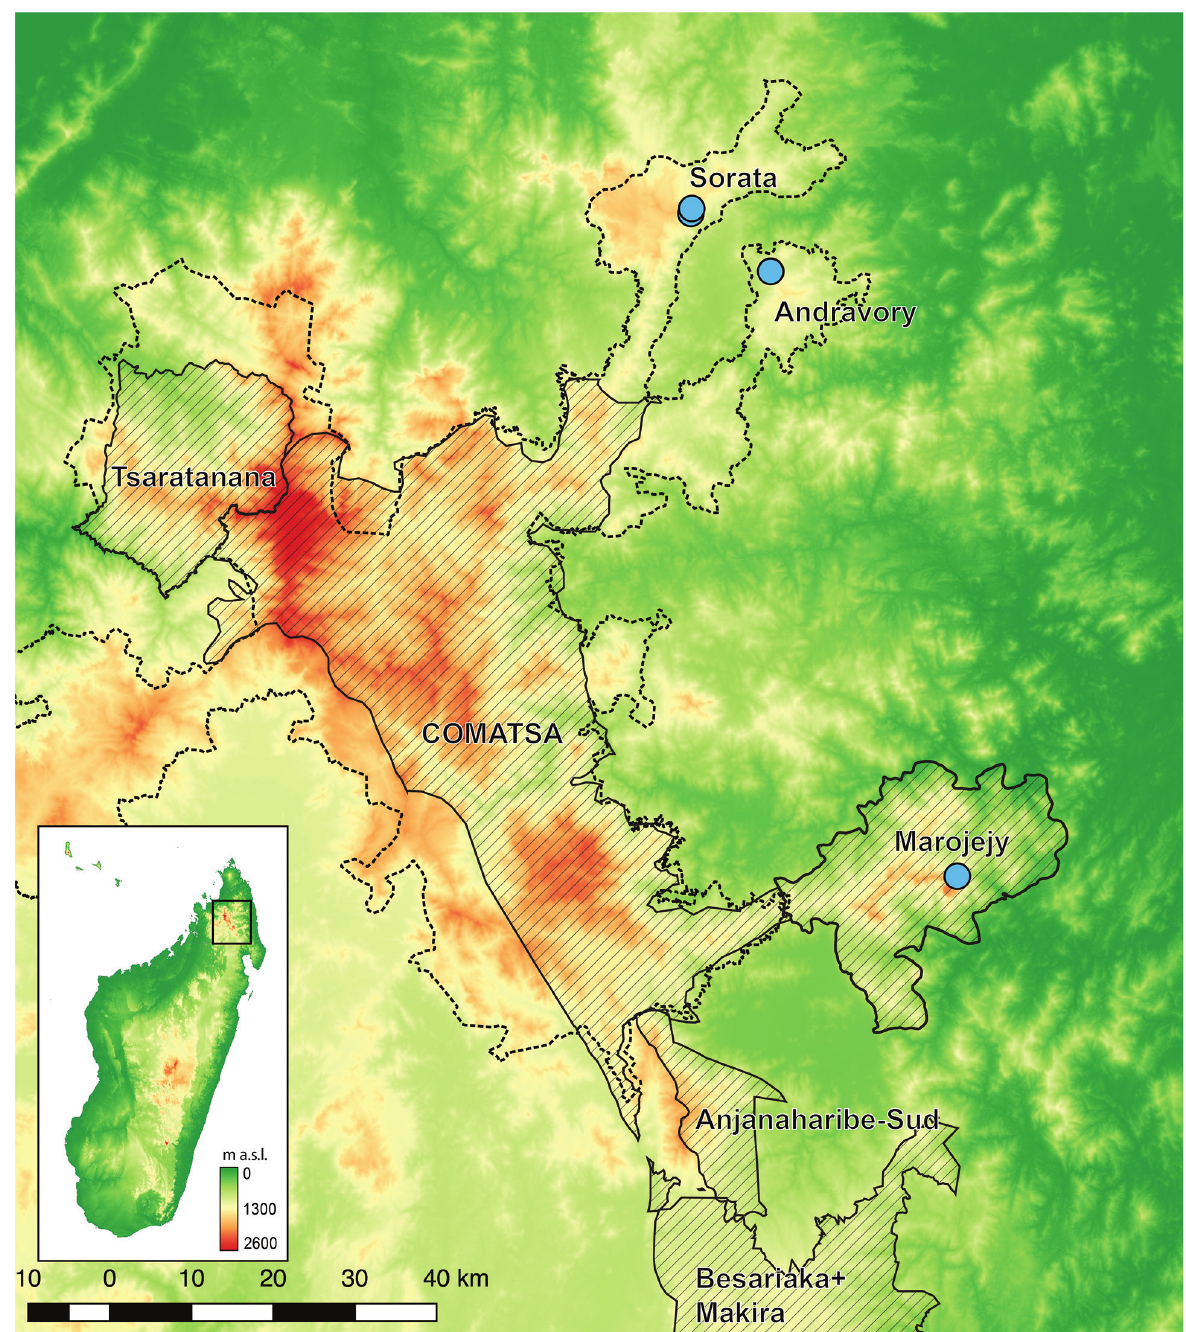
Figure 6. Distribution of Gephyromantis ( Vatomantis ) lomorina sp. n. in northern Madagascar. Areas with diagonal lines are official protected areas. The dotted outline indicates the proposed area with the scope of the WWF protection plan for this part of Madagas- car (Biodev Madagascar Consulting 2014, WWF Madagascar 2015) . Three arc second SRTM data from Jarvis et al. (2008)